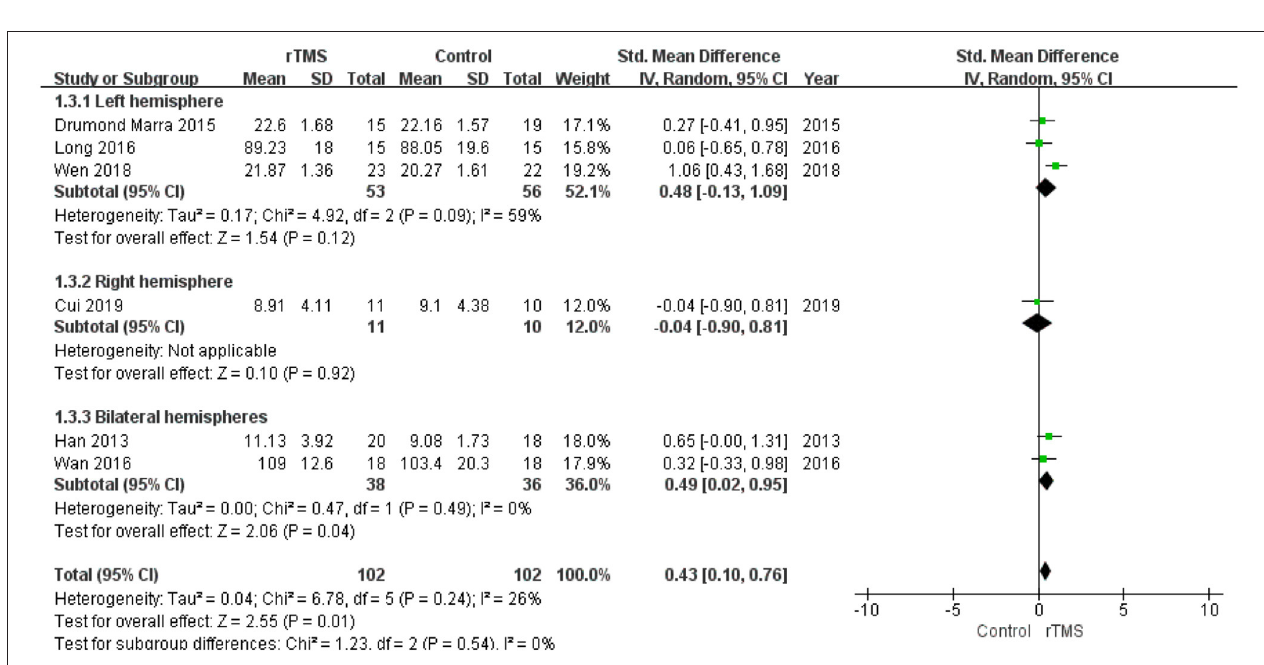
results showed no differences in dropout rate between the rTMS group and the control group (RR 0.99, 95% CI 0.39 to